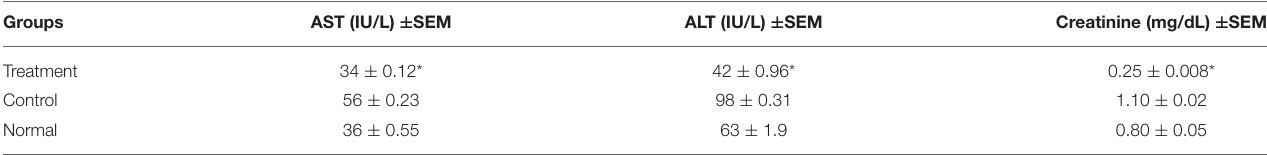
TABLE 5 | Serum ALT, AST levels (IU/L) Serum creatinine levels in (mg/dL) for different groups (treatment, negative control treated with the only vehicle, and normal untreated mice). Groups